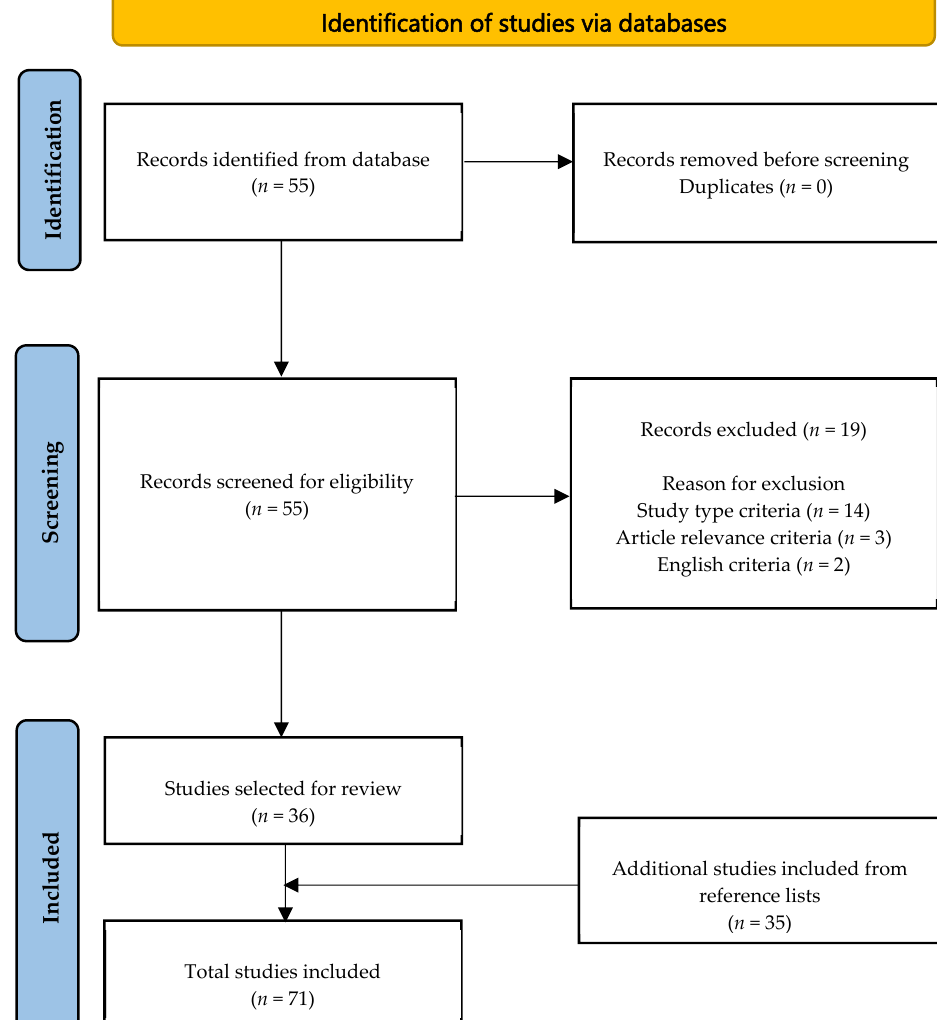
Figure 1. PRISMA flowchart for literature search.